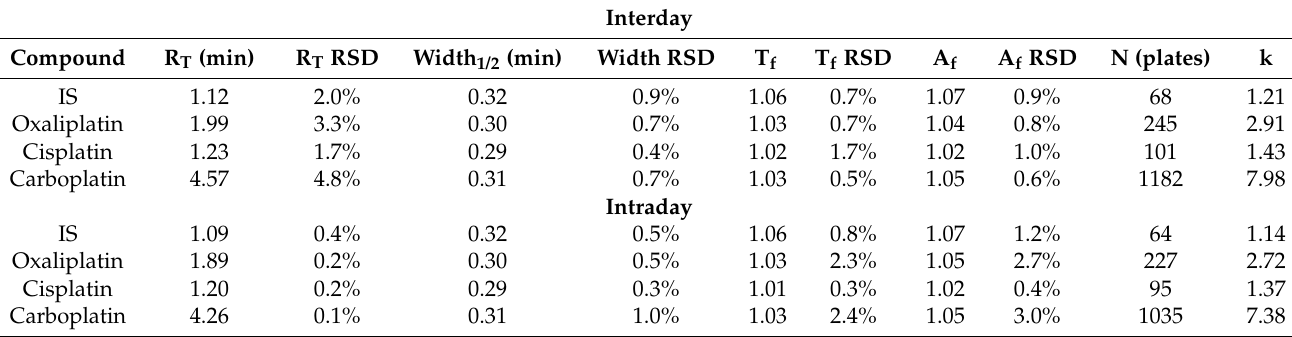
Table 3. The analytes’ retention time (R T ), peak width (Width 1/2 ), tailing factor 5% (T f ), asymmetry factor 10% (A f ), and their relative standard deviation (RSD), the calculated plate number (N), and the retention factor